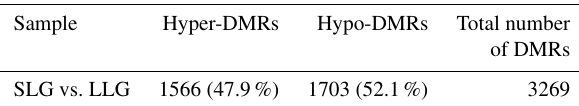
Table 3. Numbers and ratio of hyper-DMRs and hypo-DMRs.